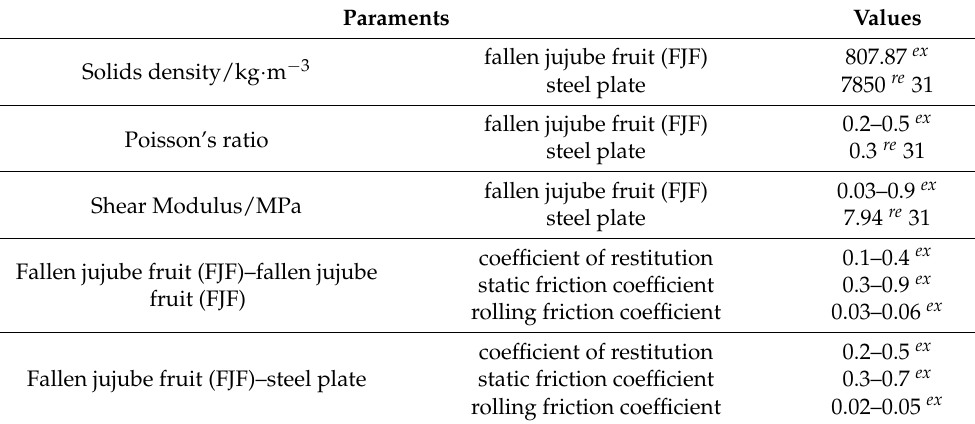
Table 1. The simulation parameters and their values for the fallen jujube fruit (FJF) and steel plate.